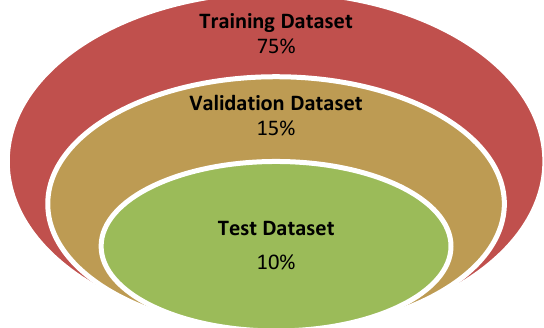
Figure 10. Visualization of the